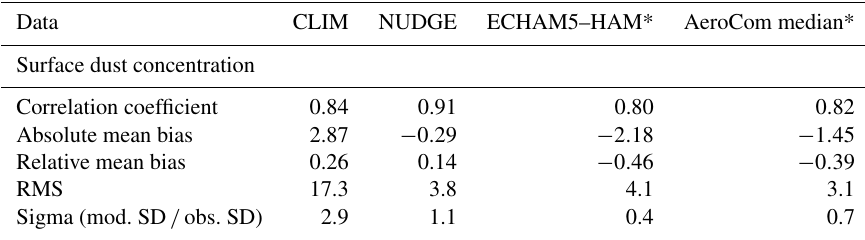
Figure 17. Locations of stations used for the evaluation of dust (DU) and sea salt (SS) aerosol. Triangles: AEROCE and SEAREX stations with dust and sea salt surface measurements. Circles: AERONET stations labeled as “dusty” by Huneeus et al. (2011). Yellow: North Africa; pink: Middle East and Asia; dark blue: Central America; light blue: marine stations. Table 4. Comparison between observed and simulated ECHAM6–HAM2 annual average dust surface concentrations at the locations of the AEROCE and SEAREX stations (see Fig.